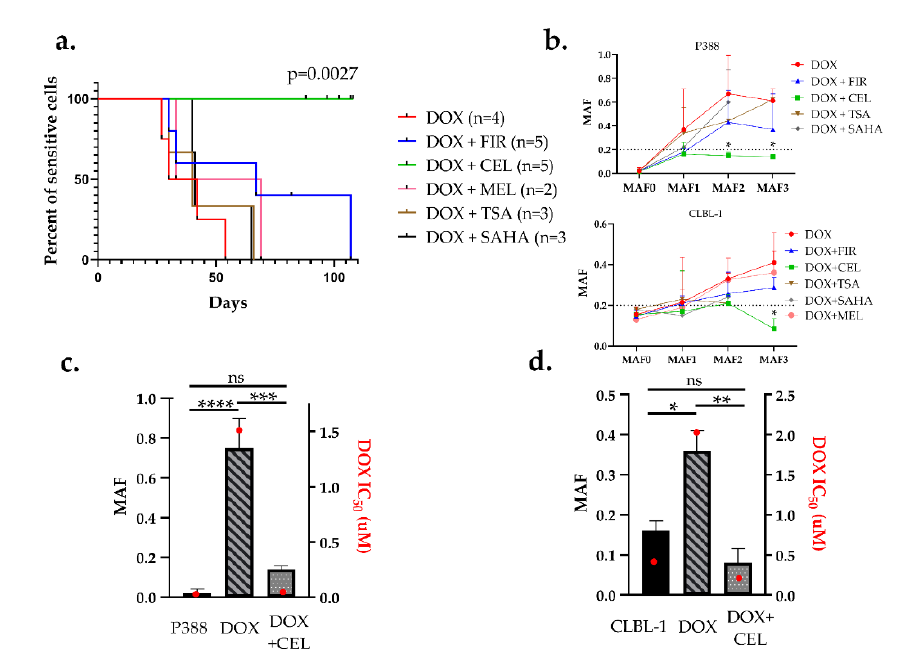
Figure 4. Celecoxib prevented the emergence of Pgp-mediated drug resistance in both P388 and CLBL-1 cells. ( a ) Kaplan–Meier curves of cell cultures treated with the indicated combinations. Cells were considered resistant at MAF ≥ 0.2. DOX (red) in combination with firocoxib (blue), celecoxib (green), meloxicam (pink), trichostatin-A (brown), and SAHA (black) were treated in 9 sequential treatment cycles. ( b ) Quantitative evaluation of multidrug resistance during the course of various treatments in P388 and CLBL-1 cells. MAF was measured after every third treatment cycle (MAF1–3). ( c , d ) Relation of MAF and drug sensitivity. MAF (patterned bars) and DOX IC 50 values (red squares) of parental (sensitive), DOX-treated, and DOX + CEL-treated ( c ) P388 cells, and ( d ) CLBL-1 cells, measured after 9 sequential treatment cycles (at around day 100). Statistical analysis was performed on MAF values, * p < 0.05, ** p < 0.01, *** p < 0.001, **** p < 0.0001, ns: not significant.